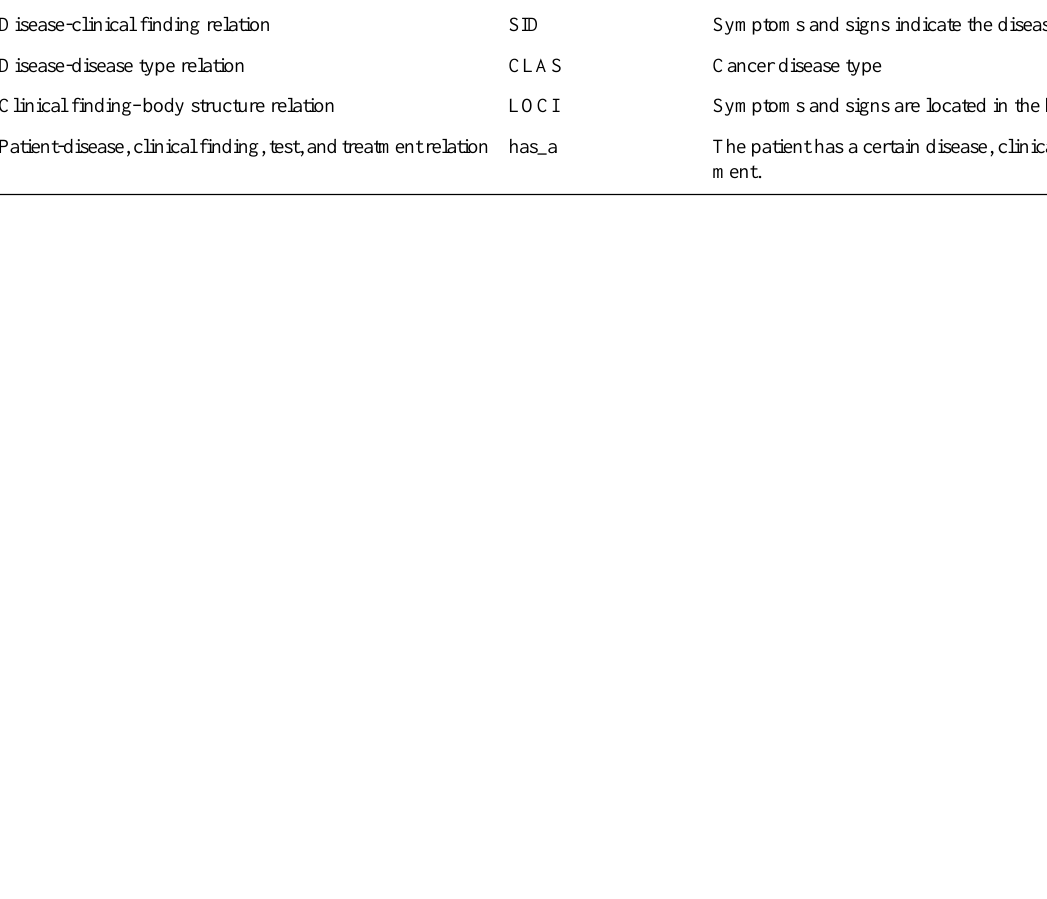
DefinitionSemantic relationshipCoarse-grained